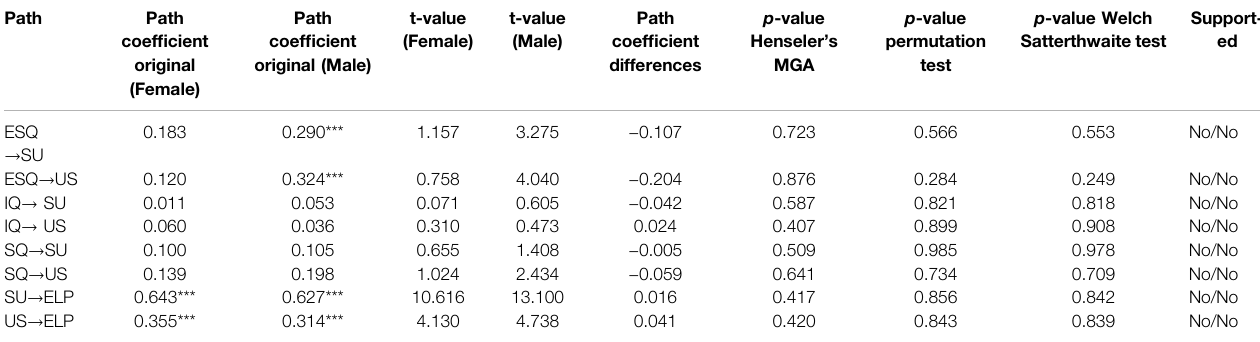
TABLE 9 | Assessment of group